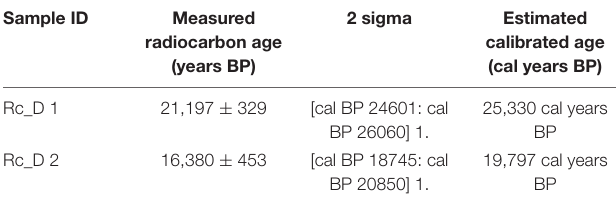
TABLE 1 | AMS radiocarbon ( 14 C) age data from Dwarahat